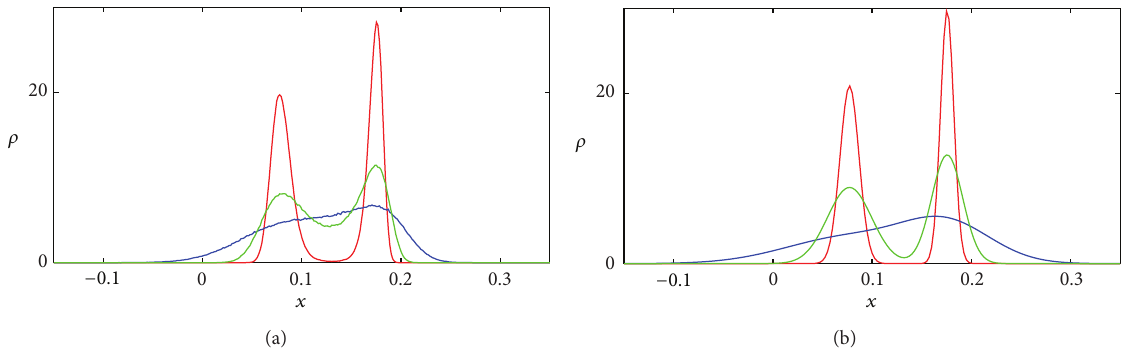
Figure 5: Backward stochastic bifurcation for 𝛾 = −3.9 . Probability density functions for 𝜀 = 0.003 (red), 𝜀 = 0.007 (green), and 𝜀 = 0.02